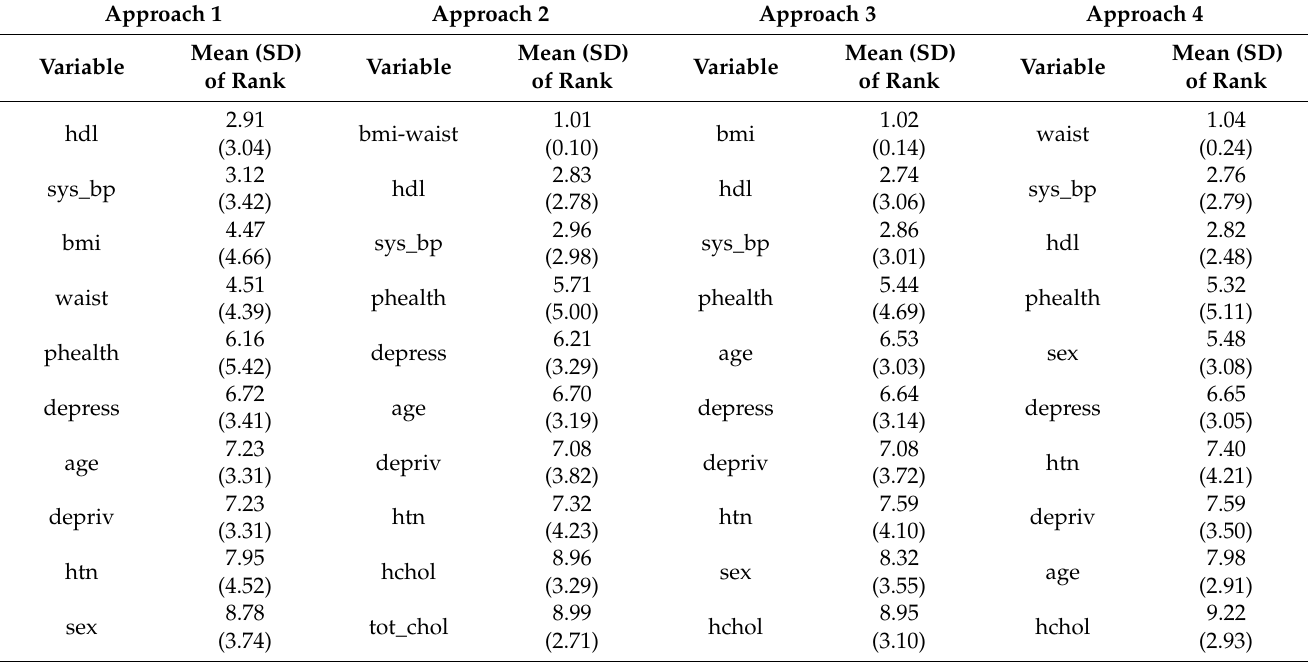
Table 5. Results of variable ranking for the predictive model of T2D